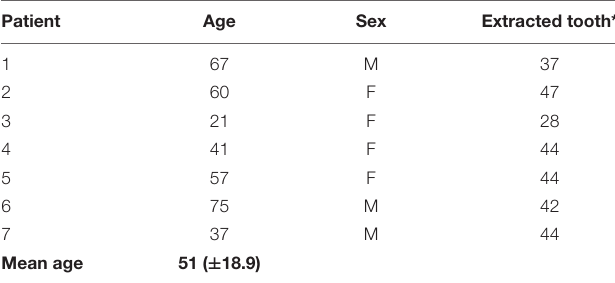
TABLE 2 | Extracted tooth, age and sex of the